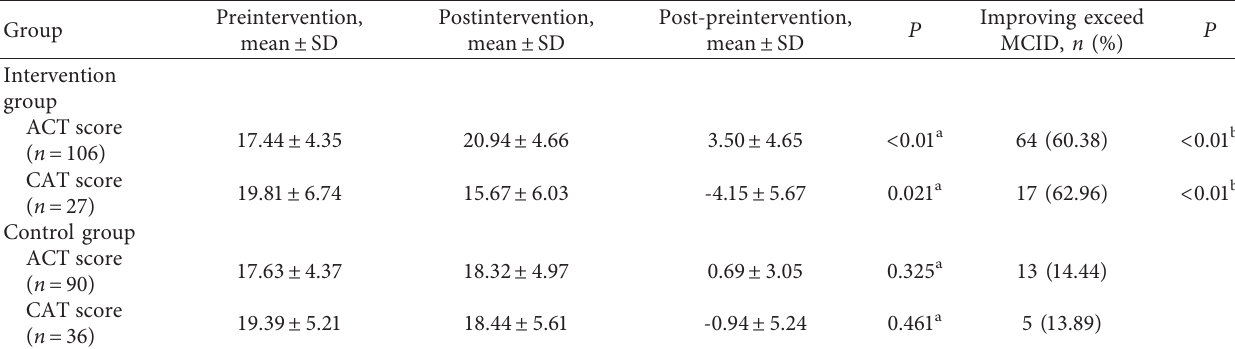
Table 4: Quality of life in the intervention group and control group pre- and postintervention.